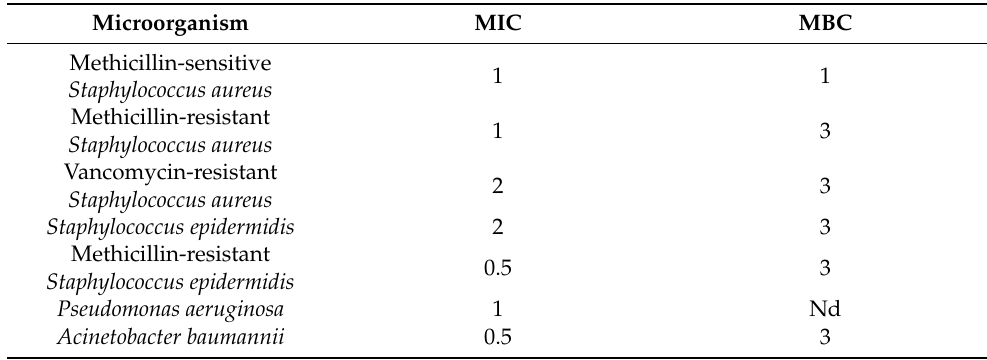
Table 1. MIC and MBC values obtained for NDYE against the target microorganisms. All results are given in mg/mL of NDYE. nd—not determined.